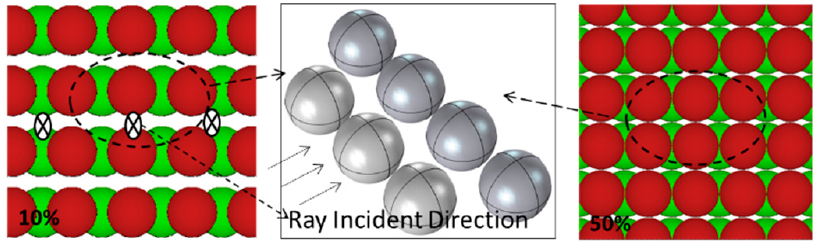
Figure 4. Two-dimensional SA Model (10 vol.% on the left and 50 vol.% on the right) and three- dimensional SA Model unit.